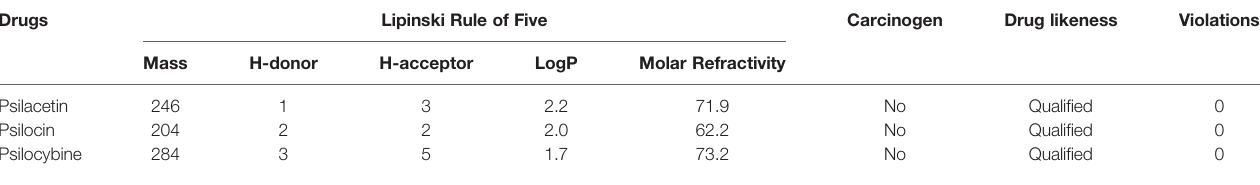
TABLE 1 | Lipinski fi lter and ADMET properties of psilacetin, psilocin, and psilocybine. Drugs Lipinski Rule of Five